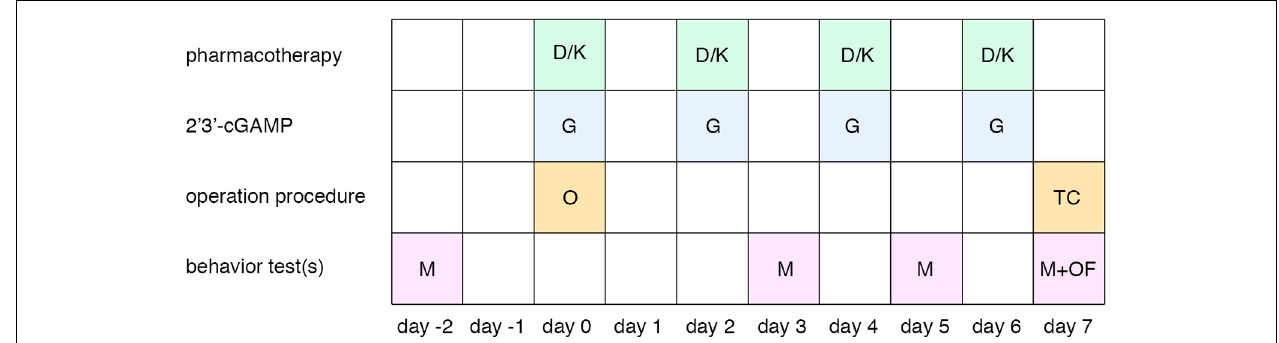
FIGURE 1 | Timeline of the experimental procedure. Abbreviations: D, dexmedetomidine administration; K, ketamine administration; G, 2’3’-cGAMP administration; O, spinal nerve ligation operation; TC, tissue collection; M, mechanical withdrawal threshold; OF, open field test.